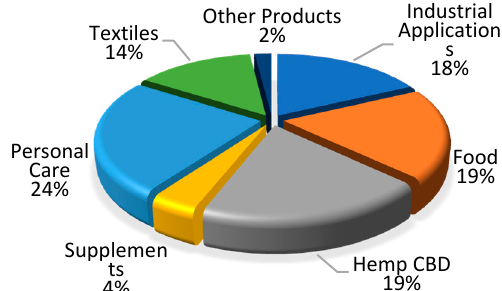
Figure 2. Hemp products sales by category, 2015, based on HIA, “2015 Annual Retail Sales for Hemp Products Estimated at 573 million of USD”, 9 May 2016.